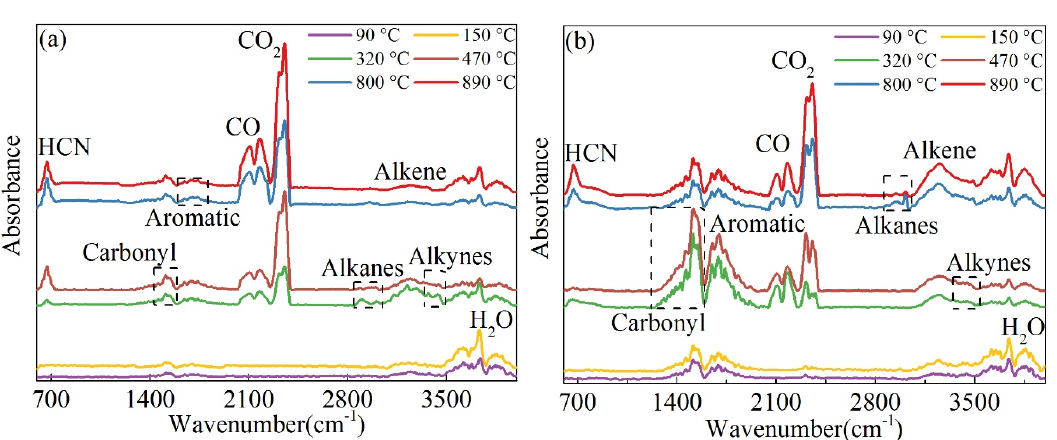
Figure 3. The infrared absorbance spectra of gas products under different stages obtained from ( a ) the sample with 100 wt.% coal and ( b ) the sample with 100 wt.% cyanobacteria.